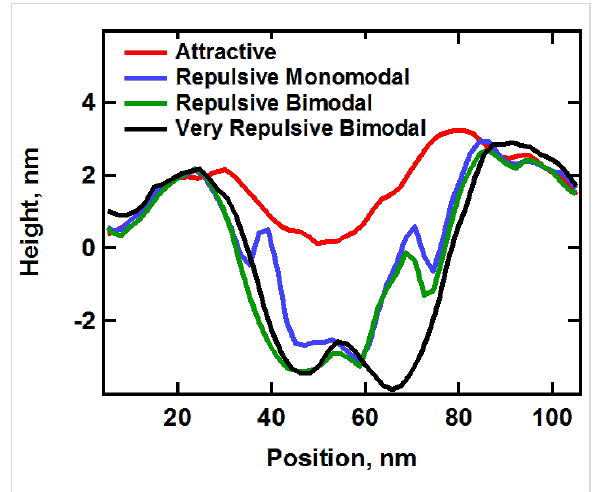
Figure 7: Scan line profiles along the dashed line indicated in Figure 6a for the images shown in Figure 6a (attractive), Figure 6b (repulsive monomodal), 6c Figure (repulsive bimodal) and Figure 6e (very repulsive